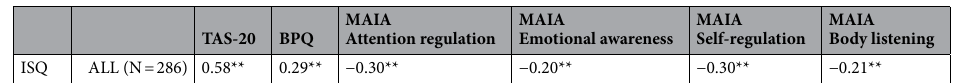
MAIA MAIA Self-regulation Body listening